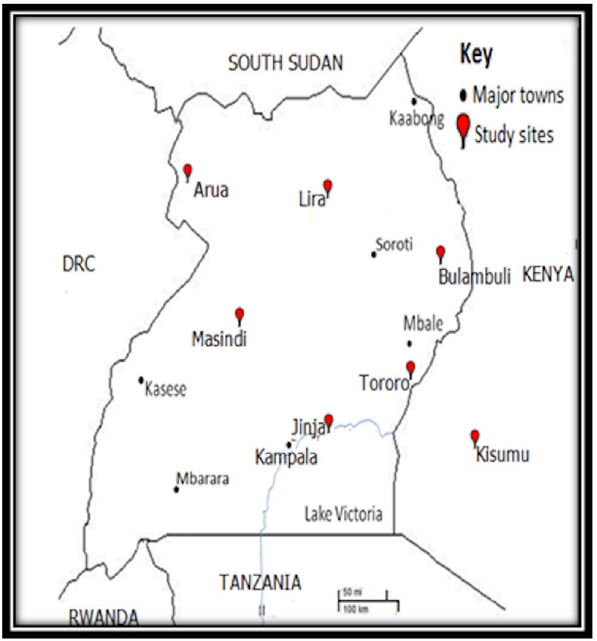
Figure 1. Map of Uganda showing study districts.